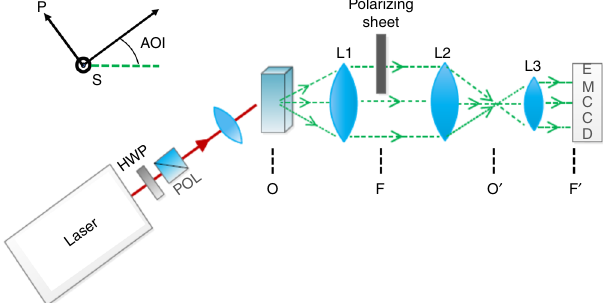
Fig. 1 Schematical depiction of the experimental setup. O and O ′ are object and image planes, respectively, F and F ′ are the Fourier plane and its image. The propagation direction and the S and P polarization directions are indicated as well. The fundamental beam is indicated in red, the second harmonic in green. Note that the incident light is aligned under an angle of incidence (AOI) with respect to the optical axis of the collection system. HWP half-wave plate, POL